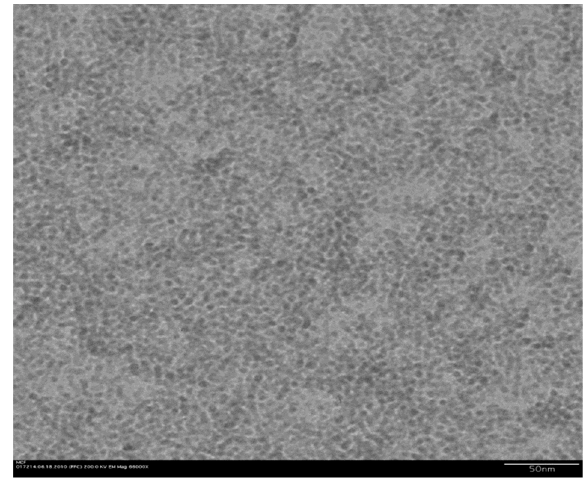
Figure 6. TEM (transmission electron microscope) image of the sample investigated. With respect to Figure 1 in reference [10], the PbS QD distribution is more dense and uniform. The bar on the right-hand side in the lower corner indicates the length of 50 nm.